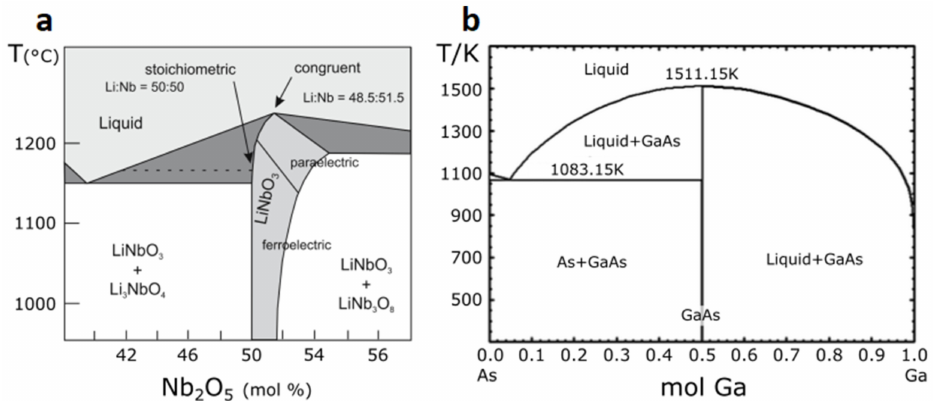
Figure 2. ( a ) The phase diagram of bulk LN adapted from Volk and Wohlecke [78] shows complex phase spaces and a narrow growth window for monophasic LN. The distinct lack of a convenient line composition creates many challenges, culminating in the need for finer control over the many growth parameters during LN epitaxy. ( b ) By comparison to LN, the phase diagram of bulk GaAs adapted from Liu et al. [79] shows that monophasic GaAs is grown, regardless of the growth ratio of As to Ga, ultimately making the epitaxial process less